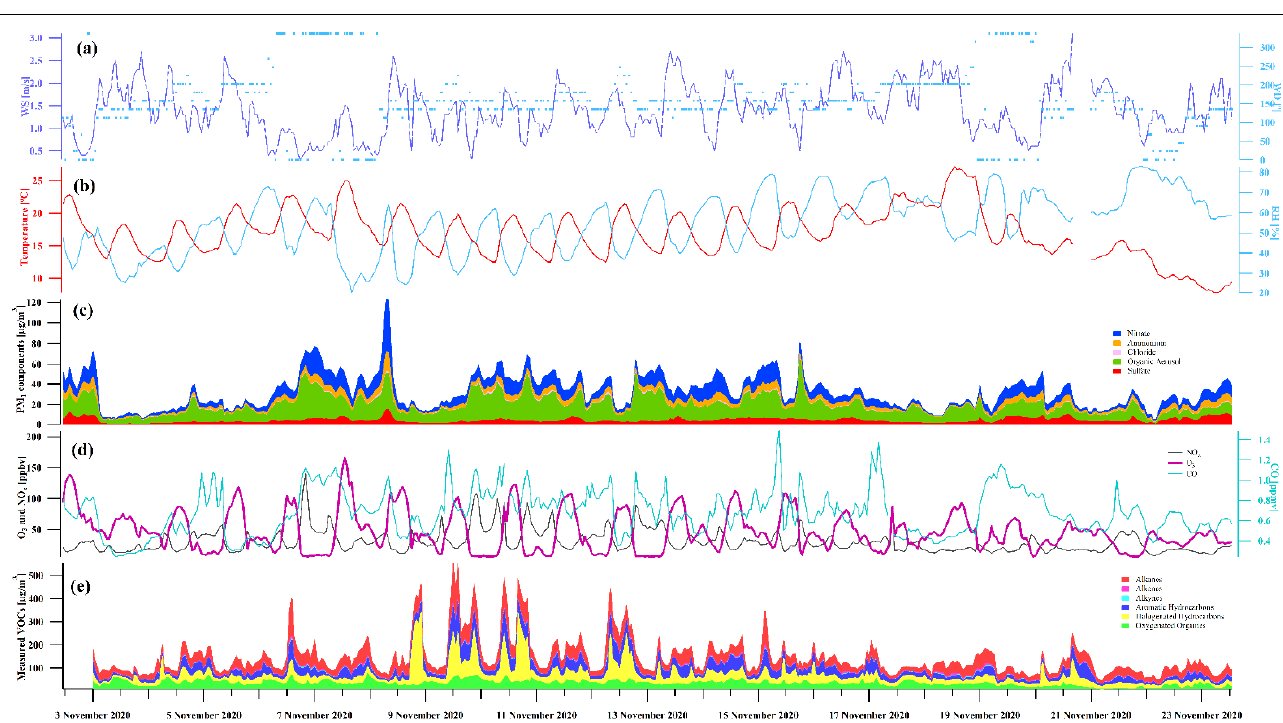
Figure 1. Time series of ( a ) wind direction (WD) and wind speed (WS); ( b ) relate humidity (RH) and temperature; ( c ) PM 1 compositions; ( d ) O 3 , NO x , and CO; ( e ) measured VOCs. The concentrations of NO x and CO were 30 ± 18 ppbv and 0.68 ± 0.62 ppmv, respec- tively. The concentration of PM 2.5 was 35 ± 20 μ g/m 3 , varying from 2 μ g/m 3 to 122 μ g/m 3 . The concentration of PM 1 was 32 ± 17 μ g/m 3 , accounting for 91% of the total PM 2.5 mass, among which OA was the main contributor (46.1%), followed by nitrate (26.3%), sulfate (13.9%), ammonium (12.2%), and chloride (1.5%). The concentration of measured VOCs was on average 44.2 ± 22.7 ppbv and alkanes were predominant (35.5%), followed by OVOCs (23.4%), halogenated hydrocarbons (19.3%), aromatics (12.2%), alkenes (6.0%), alkynes (3.5%), and biogenic volatile organic compounds (BVOCs, 0.1%). The concentrations of measured VOCs are listed in Table S1. The concentrations of measured VOCs, EC, and OC are exhibited in Table 1. The pol- lution level of this site is comparable to that of Beijing (BNU site). Because of its location in the “Nanjing-Shanghai” riverside industrial belt and downwind zone, the Changzhou site is a regional receptor site in the YRD region. The Changzhou site was found to have a higher concentration of VOCs while comparable concentration of carbonaceous aerosols in the YRD region, indicating that Changzhou was influenced distinctly by industrial transport. Table 1. Comparisons of measured VOCs and carbonaceous aerosols with other sites in the YRD region.